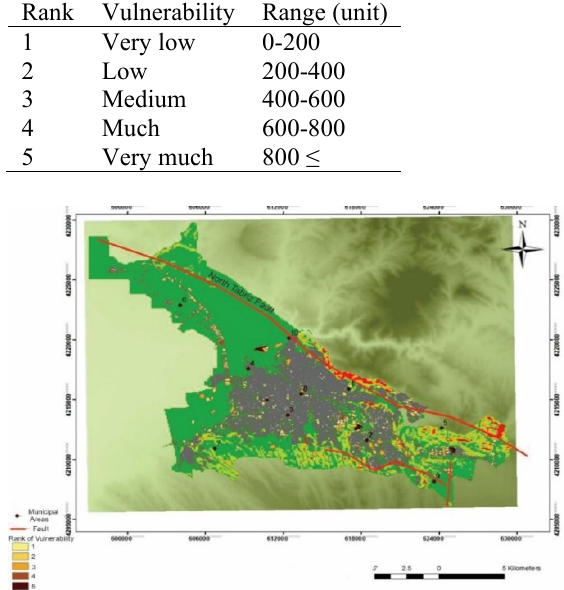
Fig. 7. Vulnerability map of Tabriz city based on building